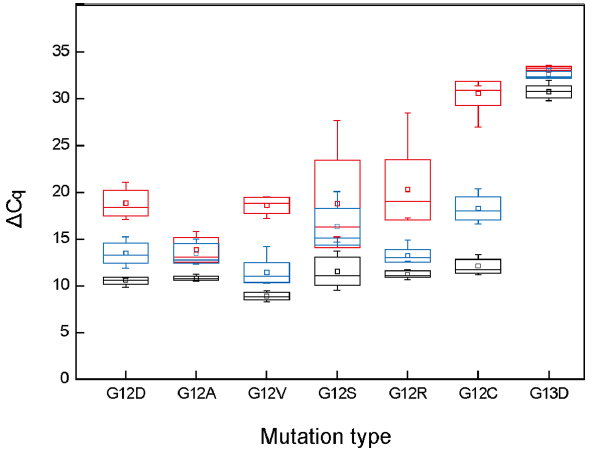
Figure 4. The limit of detection of the two-color duplex real- time Bi-PAP for each KRAS mutation in the presence of 100 ng wild-type genomic DNA. For each mutation, the D Cq values for wild- type (red), 0.01% mutant (blue), and 0.1% (black) were detected in 10 replicates and calculated. The line within the box denotes the median, the square within the box denotes the mean, the horizontal borders of each box denote the SD, and the whiskers denote the minimum and